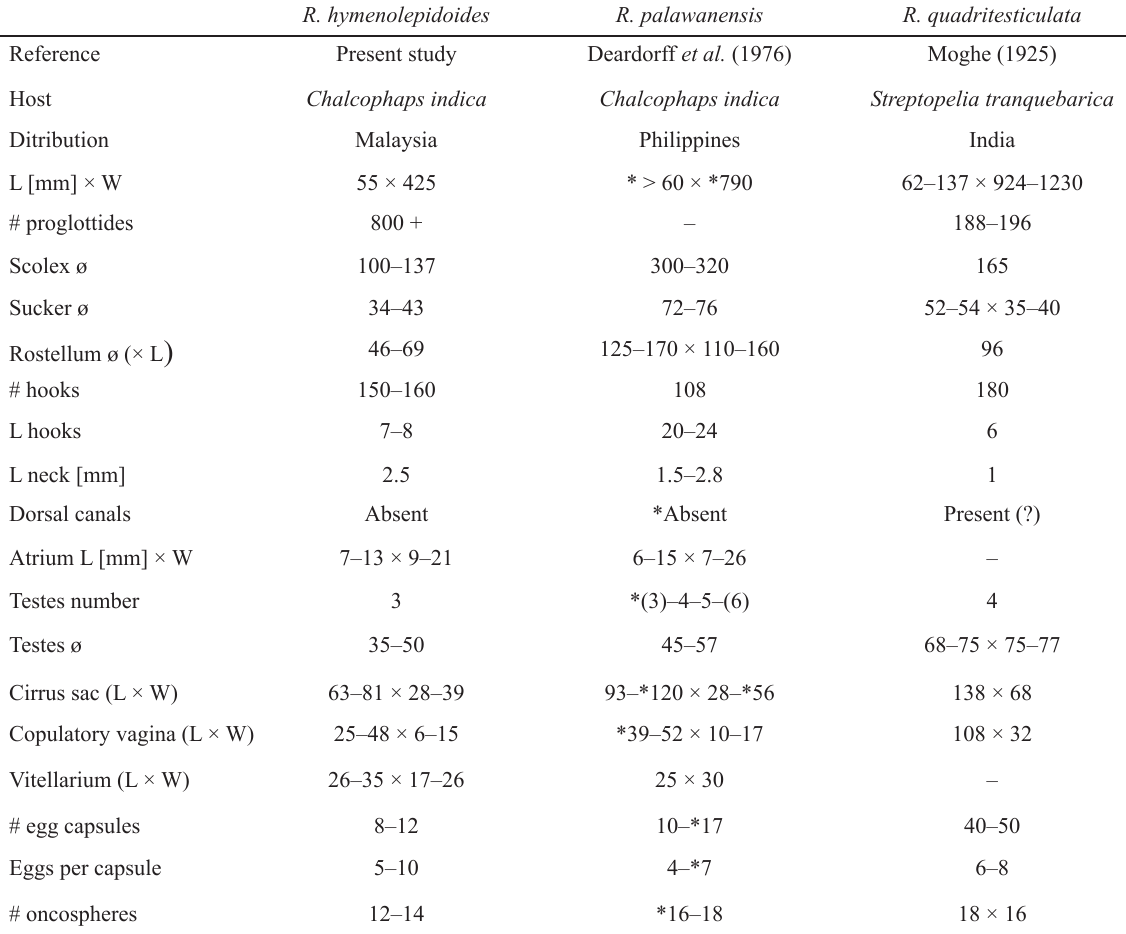
Table 2. Main morphological characteristics of Raillietina hymenolepidoides sp. nov. and closely similar taxa. * New values from our observations of type material. Abbreviations: L = Length; W = Width; ø =